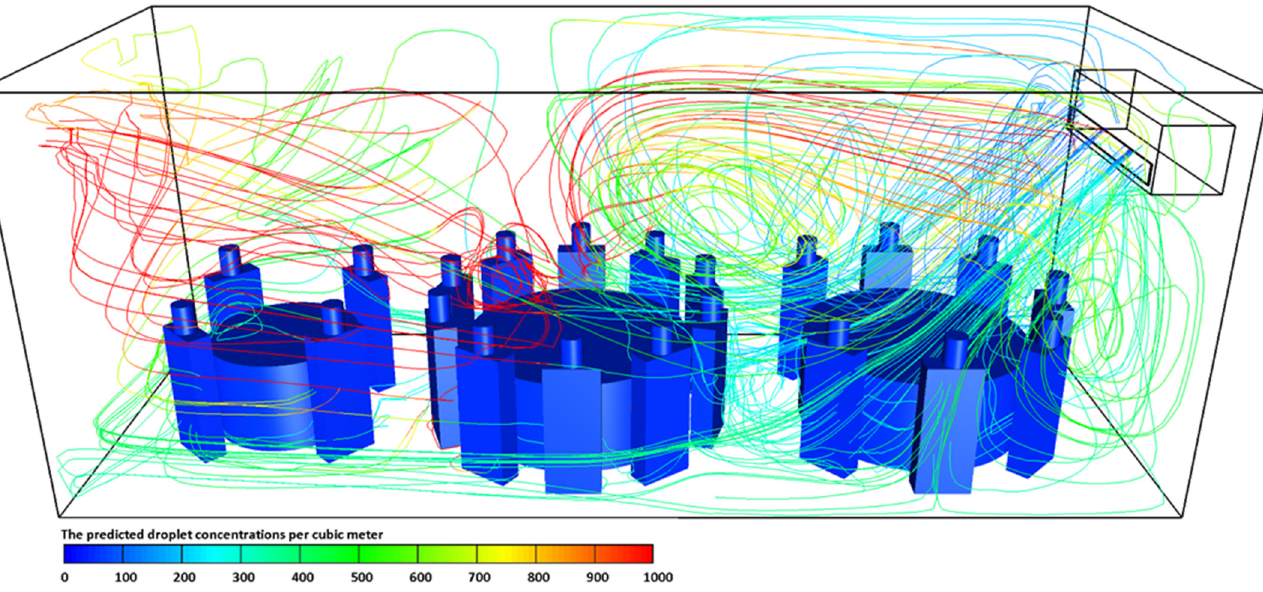
Figure 7. The predicted droplet concentrations per cubic meter exhaled from index case (T2C1) at t = 4500 s for case-3.